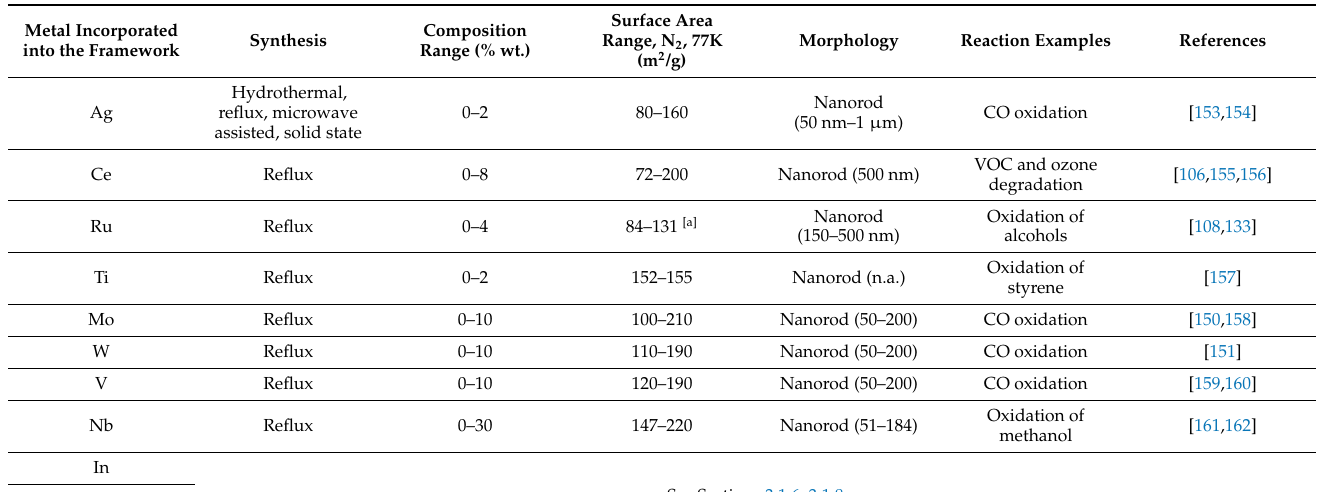
Table 2. Chemical composition and textural information of [M]–K–OMS–2 materials.